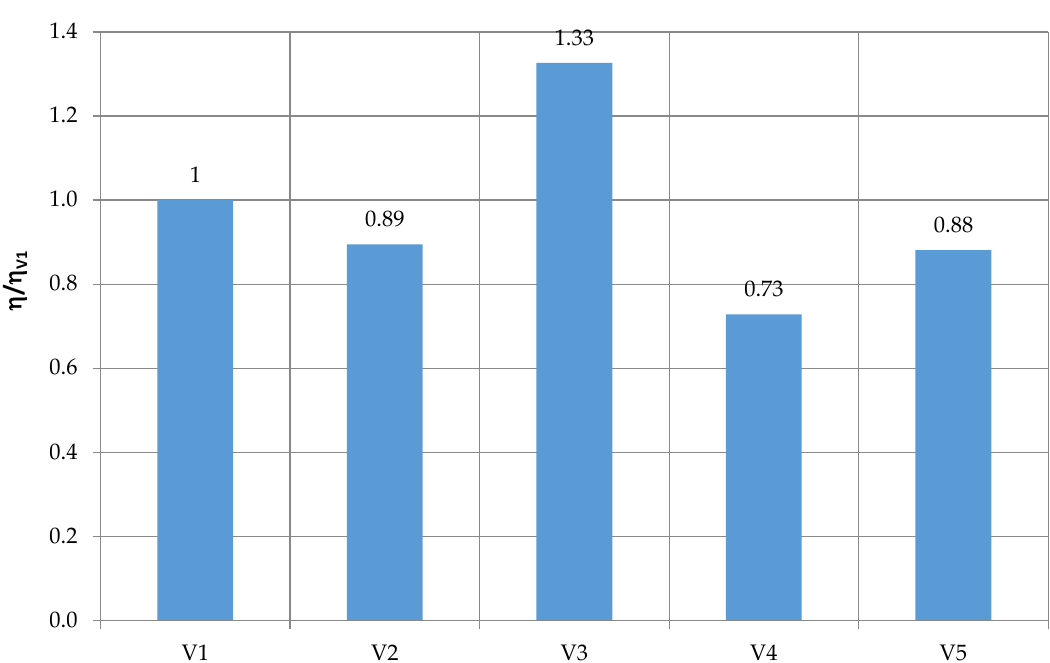
Figure 4. The e ff ect of the cycle structure on its e ffi ciency as compared to variant 1 for heating value Energies 2019 , 12 , x FOR PEER REVIEW Figure 4. The effect of the cycle structure on its efficiency as compared to variant 1 for heating value W d = 4 MJ / kg. W d = 4 MJ/kg.